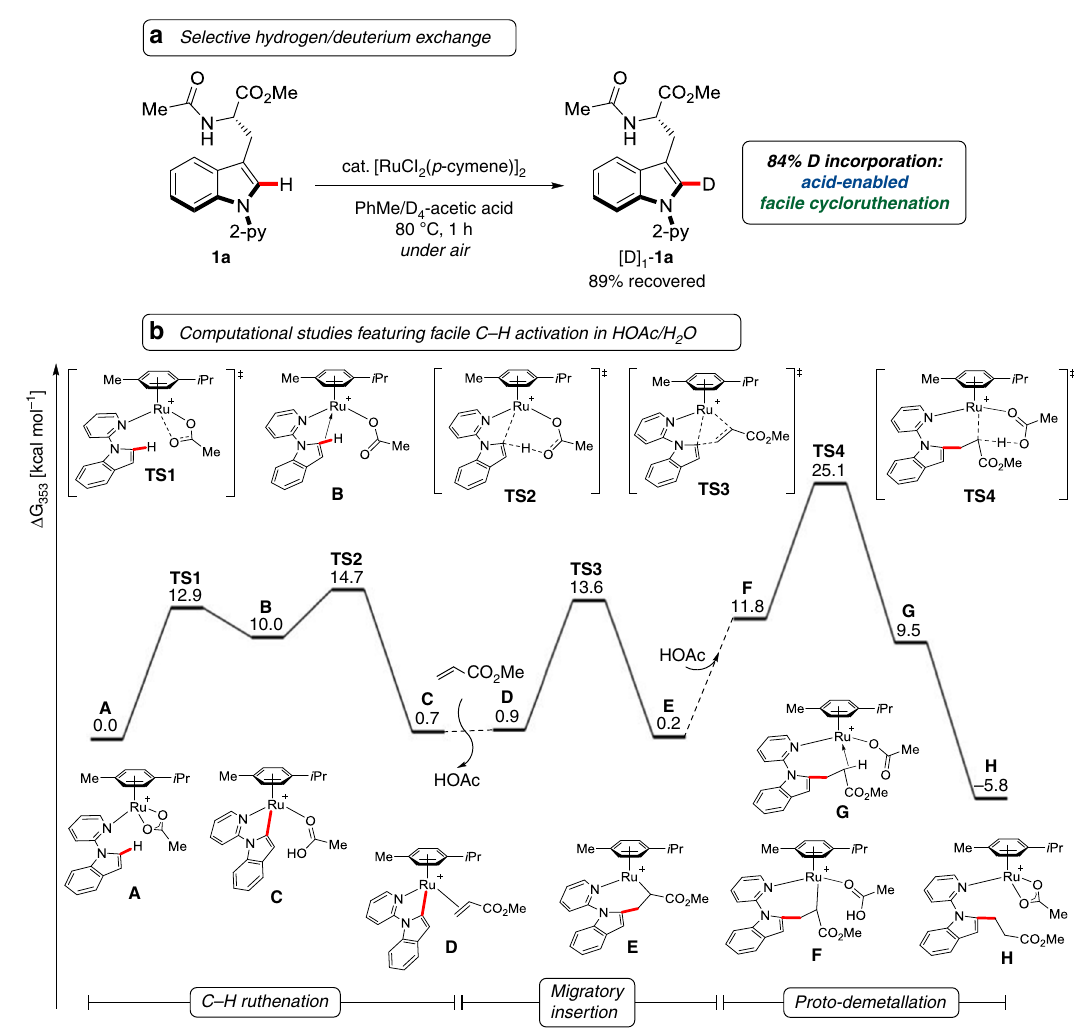
Fig. 2 Ruthenium-catalyzed C – H alkylation for peptide diversi fi cation. a Experimental evidence for facile C – H cleavage by selective H/D scrambling; b Calculated Gibbs free energy pro fi le for the C – H alkylation at the PW6B95-D3(BJ)/def2-QZVP* + SMD(AcOH)//M06-D3/def2-SVP level of